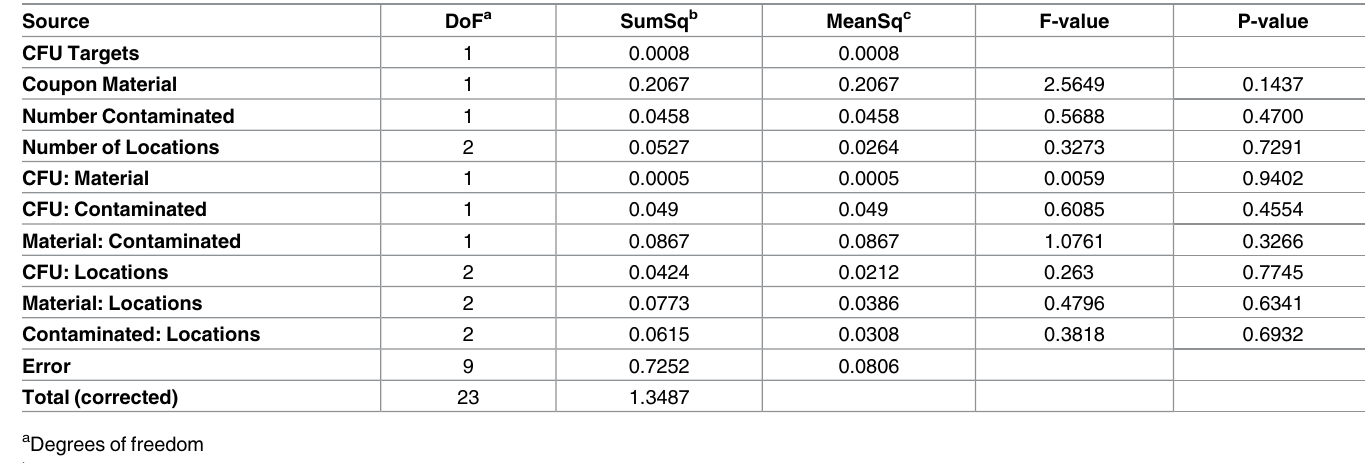
Table 3. ANOVA results for experiments with 16 locations composited using the MM-MPC